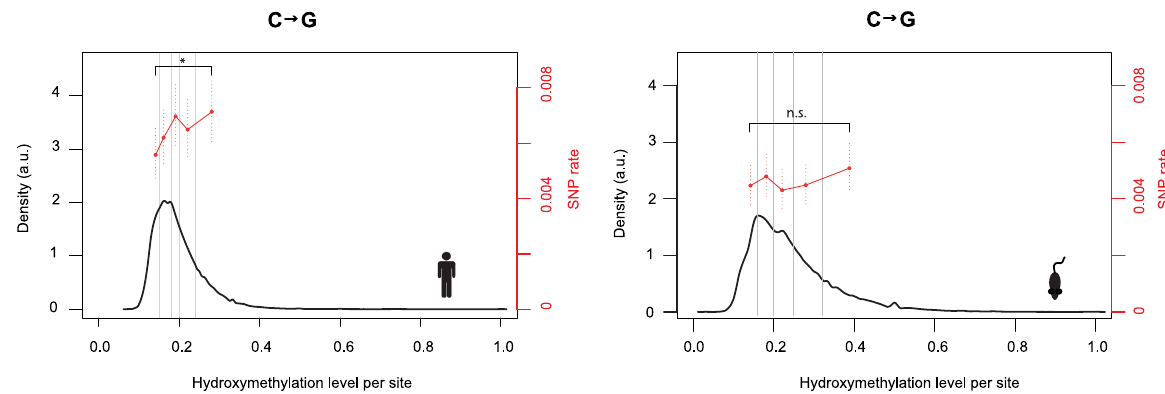
Figure 3. Hydroxmethylation levels correlate with C to G rates. Density plots depict the distribution of hydroxymethylation levels at 5hmC sites for the human and mouse genome. To calculate C to G SNP rates as a function of hydroxymethylation levels (% reads supporting hydroxymethylation at a given cytosine in [15]), cytosines were assigned to bins (demarcated by vertical lines) according to their hydroxymethylation levels and a single rate estimate was derived for each bin. Bin sizes were chosen so that each bin contains the same number of C to G changes (N=155 for human, N=138 for mouse). C to G SNP rates were then compared for the terminal bins (*P , 0.05). Error bars are 95% confidence intervals, calculated using Wilson’s interval score for single